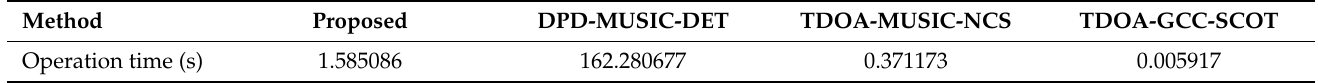
Table 2. Comparison of operation time.